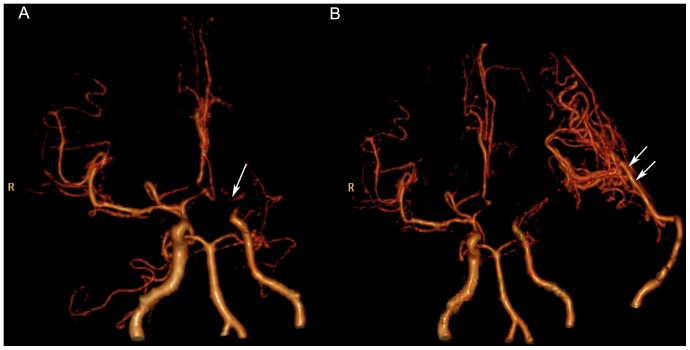
CT Angiography (CTA) images in frontal projection before and after bypass in Moyamoya disease.(A) The preoperative volumetric CTA acquired in the arterial phase of whole-brain CT perfusion (CTP) shows the left internal carotid artery (ICA) is occluded in the supraclinoid portion, and “Moyamoya vessels”(arrow) can be seen in the cerebral base. The right supraclinoid ICA and the proximal anterior cerebral artery (ACA) and middle cerebral artery (MCA) are markedly stenosed. (B) The arrows indicate the left-side direct graft patency with collateral vessels from the left external carotid artery to the MCA territory on the postoperative volumetric CTA acquired in the arterial phase of whole-brain CTP.